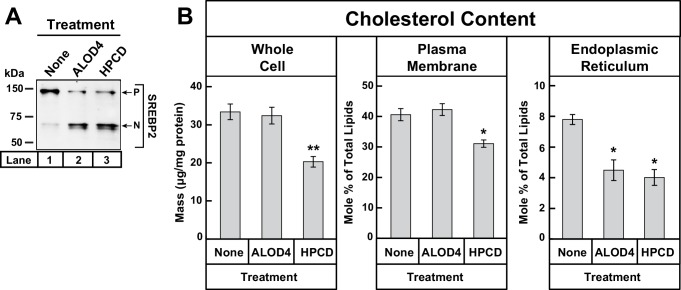
ALOD4 triggers activation of SREBP2 by lowering ER cholesterol levels while leaving PM cholesterol levels unchanged.(A–B) On day 0, CHO-K1 cells were set up in medium B at a density of 5 × 105 cells/100 mm dish (20 dishes/replicate/condition). On day 1, media was removed and fresh medium B was added. On day 2, media was removed, cells were washed with 5 mL PBS, followed by addition of 2 ml of medium B without or with ALOD4 (5 µM) or HPCD (1% w/v). After incubation for 1 hr at 37°C, media was removed, and cells were washed twice with 5 ml of PBS. After the washes, 5 ml of PBS was added to each dish and cells were harvested. An aliquot of cells (one dish/replicate/condition) was used for immunoblot analysis and quantification of whole cell cholesterol as described in Materials and methods. Another aliquot of cells (two dishes/replicate/condition) was used for PM purification and quantification of PM cholesterol, as described in Materials and methods. The remainder of cells (17 dishes/replicate/condition) was used for ER purification and quantification of ER cholesterol, as described in Materials and methods. Immunoblot of the cells from one of the three replicates for each treatment condition is shown in (A), and whole cell, PM, and ER cholesterol levels are shown in (B). Each column represents the mean of cholesterol measurements from triplicate assays, and error bars show the standard error. Asterisks denote level of statistical significance (Student t test) between cells treated without and with ALOD4 or HPCD: *p<0.05; **p<0.01. P = precursor form of SREBP2; N = cleaved nuclear form of SREBP2.